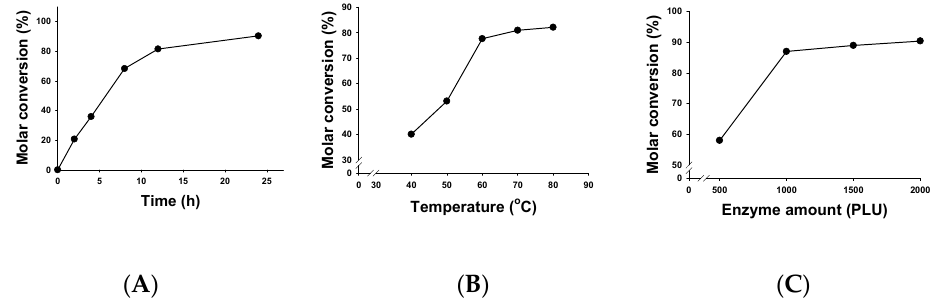
Figure 1. Effects of experimental parameters on the molar conversion of 2 ‐ ethylhexyl salicylate. ( A – C ) Effects of ( A ) reaction time, ( B ) temperature, and ( C ) enzyme amount on molar conversion of 2 ‐ ethylhexyl salicylate.